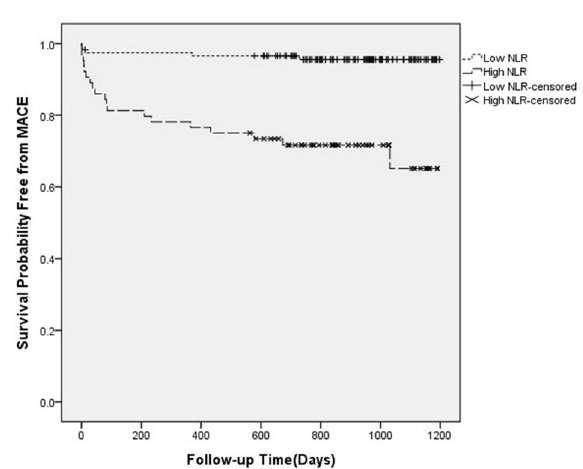
Figure 2. Kaplan–Meier survival curve of 2-year cardiovascular death in patients with high NLR and low NLR groups. NLR, neutrophil to lymphocyte